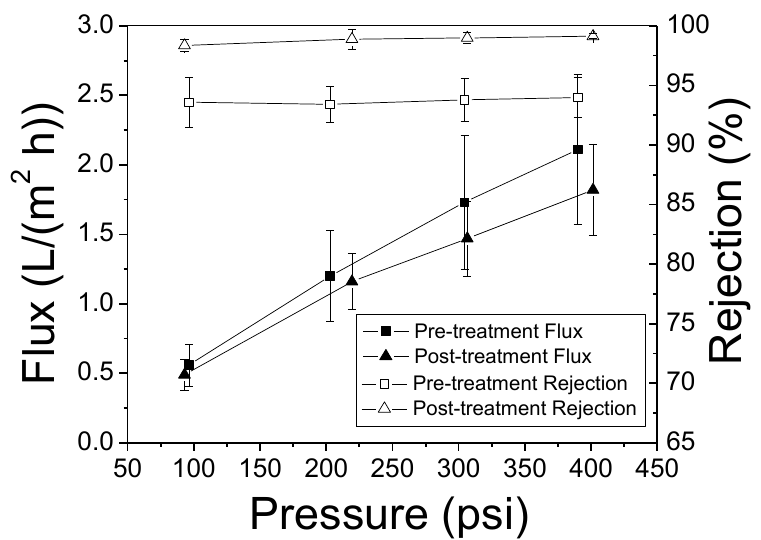
Figure 10. Pure water flux of PBI HF module (air gap = 2.5”, 6.4 cm) varied by hydraulic pressure. Figure 10 . Pure water flux of PBI HF module (air gap = 2.5″, 6.4 cm) varied by hydraulic pressure.